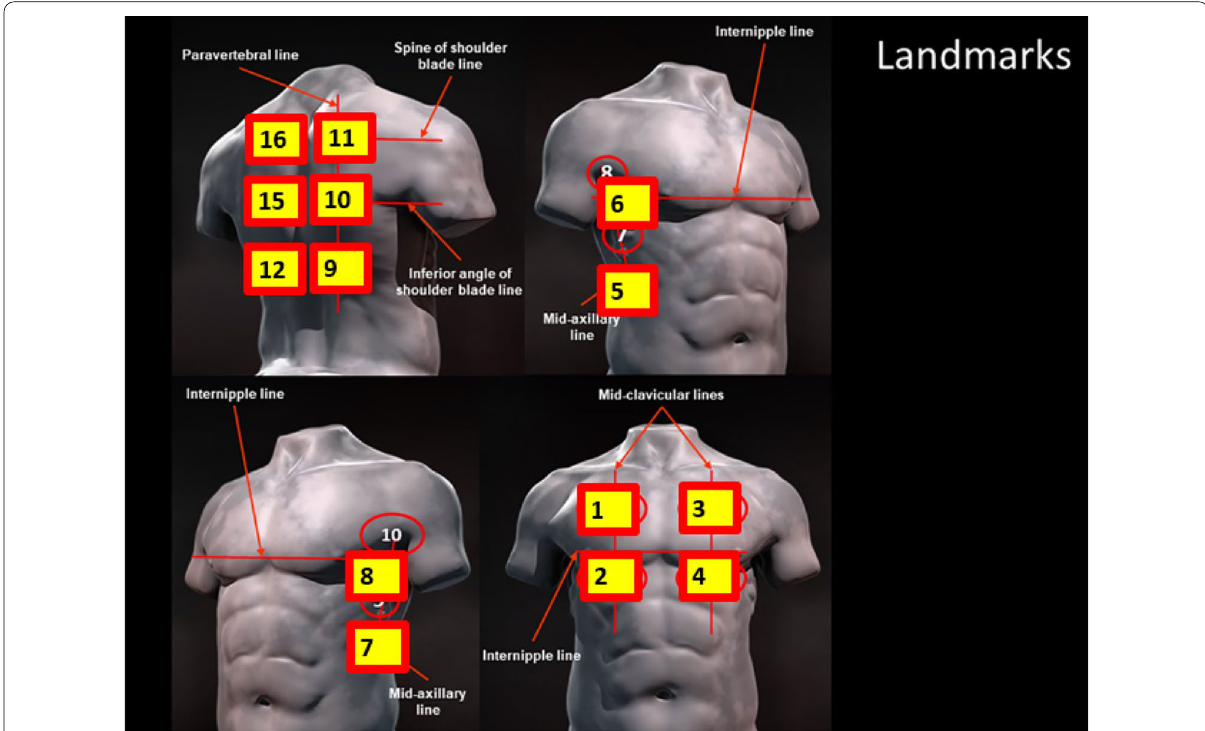
Fig. 1 Anatomic locations targeted for the self-performed lung examination. Figure [19] modified from proposal for international standardization of the use of lung ultrasound for patients with COVID ‐ 19 by Soldati et al., J Ultrasound Med 2020, published in Open Access Format